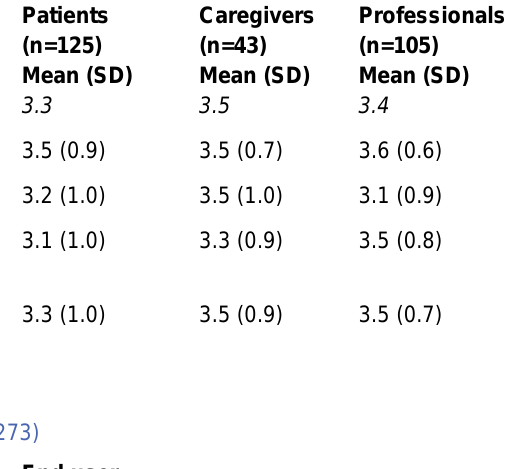
Table 2a. Importance of Requirements for Accessibility of Stroke e-Rehabilitation According to End Users (n=273) Category